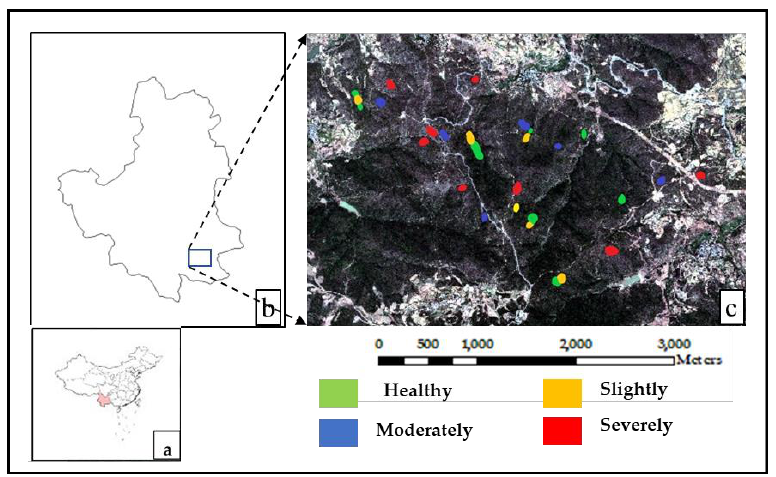
Figure 1. (a) Yunnan province in China, (b) study area location in Xiangyun County, (c) the reference Figure 1. ( a ) Yunnan province in China, ( b ) study area location in Xiangyun County, ( c ) the reference data area located in the WV-3 imagery. data area located in the WV-3 imagery.